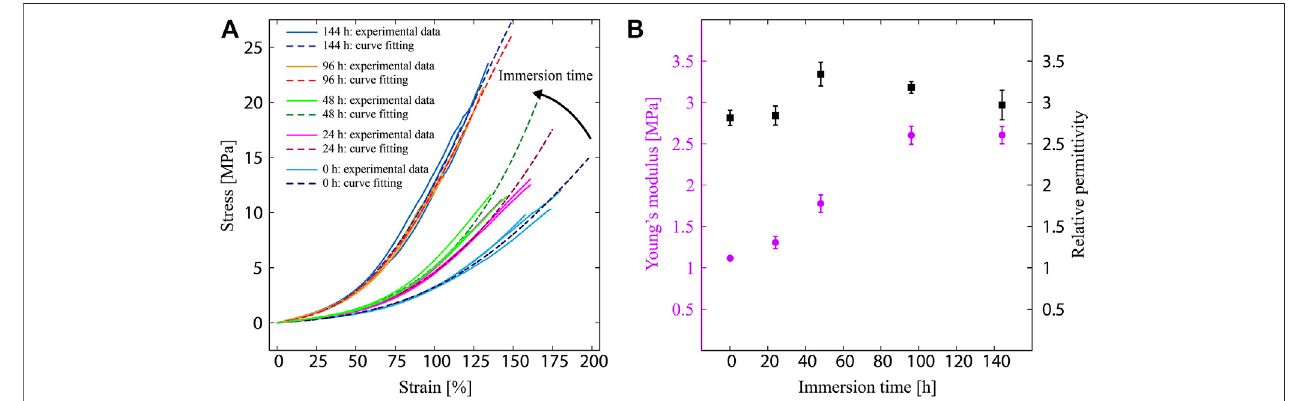
FIGURE 2 | (A) Measured stress – strain curve for the PDMS samples under different immersion times. (B) Measured Young ’ s modulus and relative permittivity of PDMS samples as function of the immersion